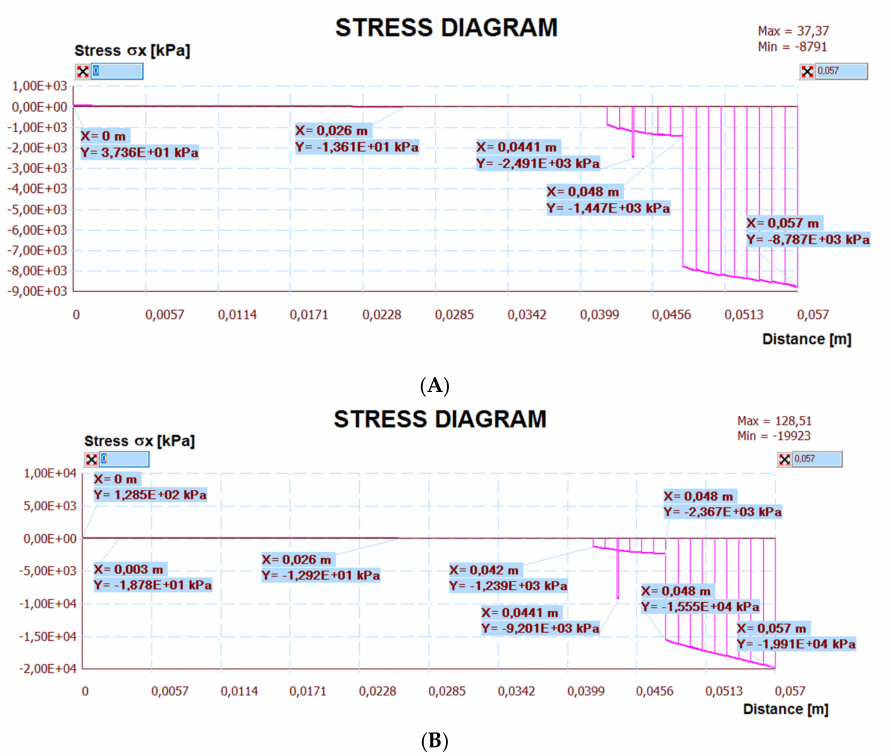
Figure 32. Diagram of horizontal stresses σ x in the II–II section: ( A ) thermal action without ceiling deflection; ( B ) thermal action and imposed load with ceiling deflection.